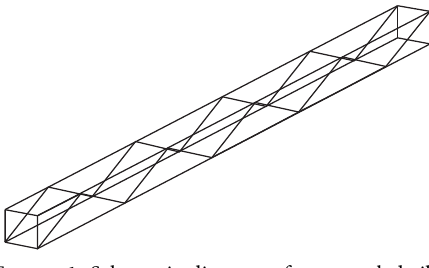
Figure 1: Schematic diagram of a concealed